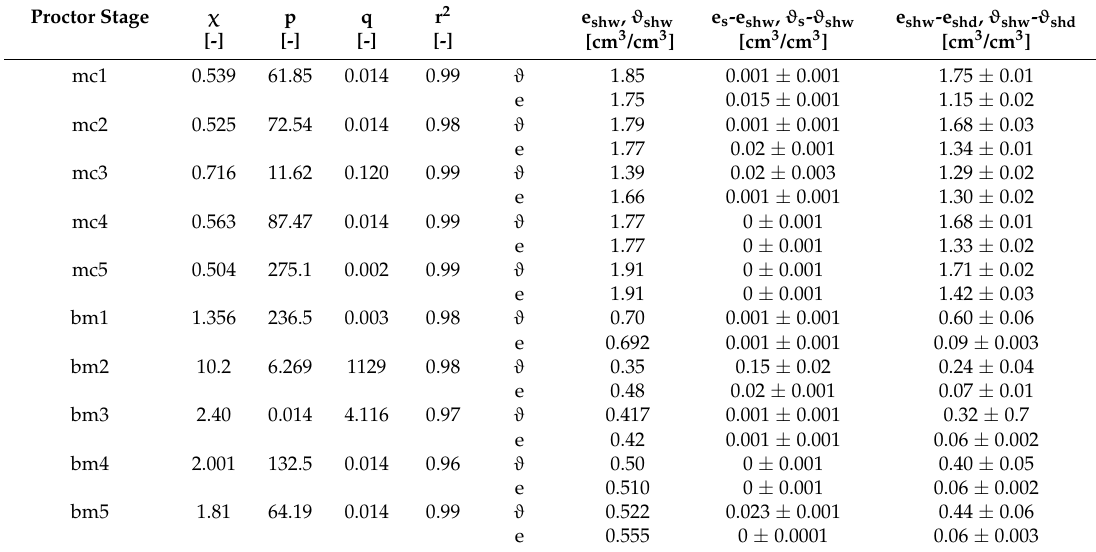
Table 4. Parameters derived from shrinkage curves of the Proctor stages of marsh clay (mc1-mc5) and boulder marl (bm1-bm5) according to a previous model [16]: saturated void and moisture ratio (e s and ϑ s ), the transition point between the structural and the proportional shrinkage phase (e shw and ϑ shw ), the change of void ratio (e) and moisture ratio ( ϑ ) during the structural shrinkage phase (e s -e shw and ϑ s - ϑ shw ), and the proportional shrinkage phase (e shw -e shd and ϑ shw - ϑ shd ). The symbol ± corresponds to the standard deviation.